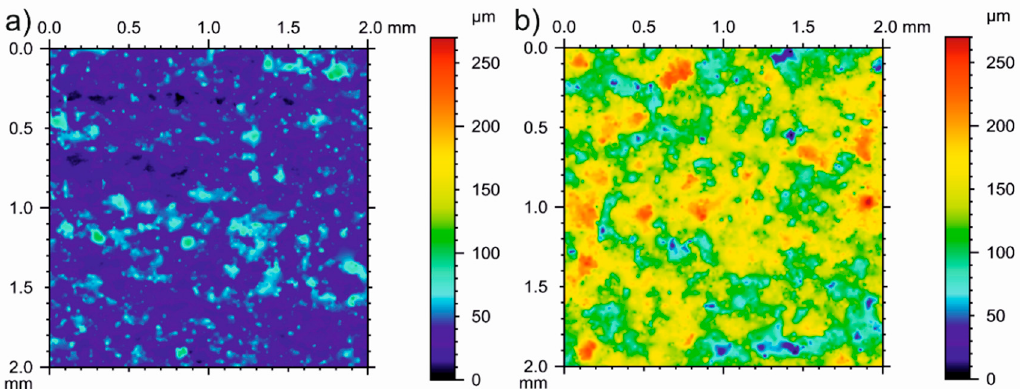
Figure 4. Roughness map of the cuboid (field of view is 2.5 mm × 2.5 mm) for ( a ) A4 with contour scan S q = 13.2 µm; ( b ) A4 without contour scan S q = 33.3 µm.